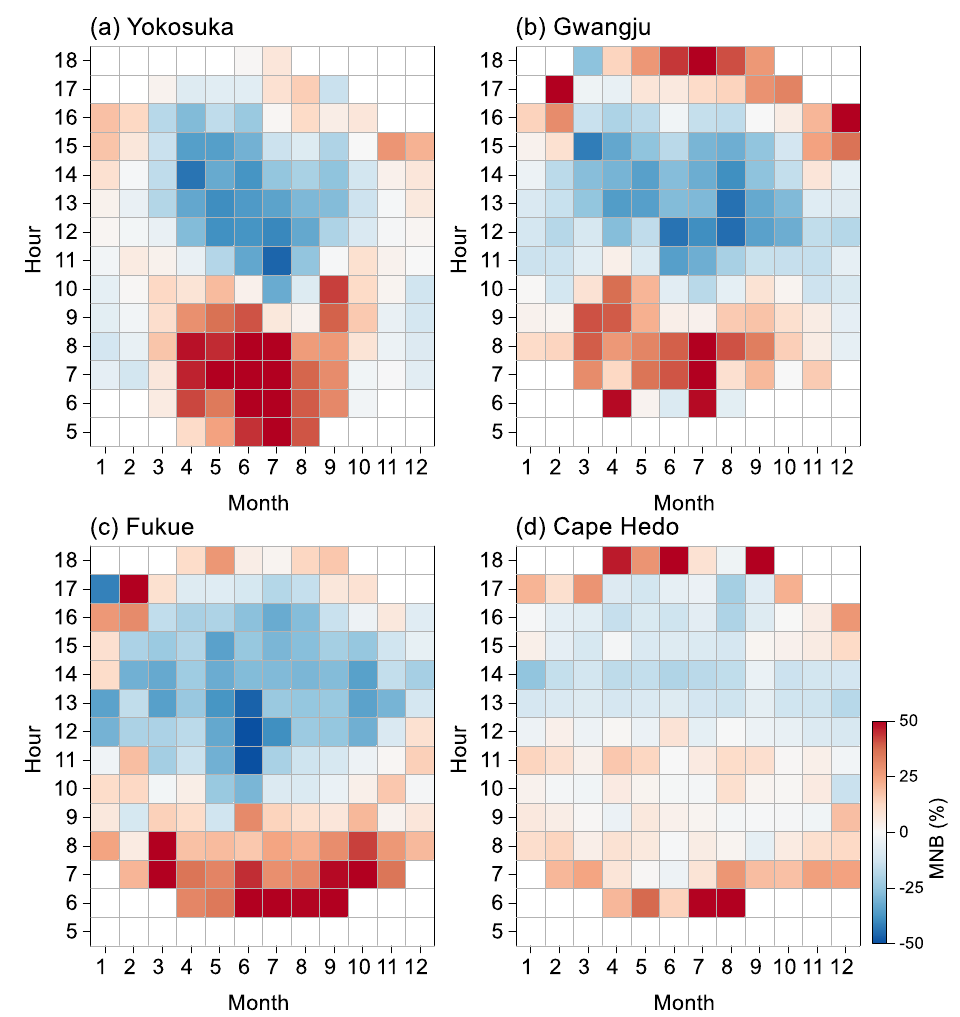
Figure 4. Monthly diurnal variation in the mean normalized bias (MNB) of NO 2 VCD at less than 1 km (VCD1km) at ( a ) Yokosuka, ( b ) Gwangju, ( c ) Fukue, and ( d ) Cape Hedo. The MNB is defined as [A − B]/B × 100, where A and B denote the hourly and daily mean NO 2 VCD1km from MAX-DOAS, respectively.